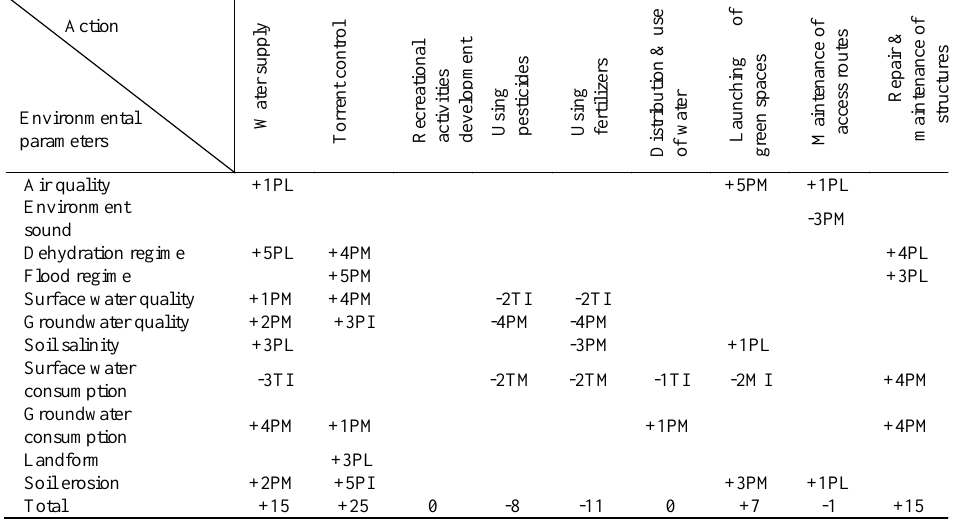
Table 6: Prediction matrix of physical impact s of irrigation and drainage network in operation phase